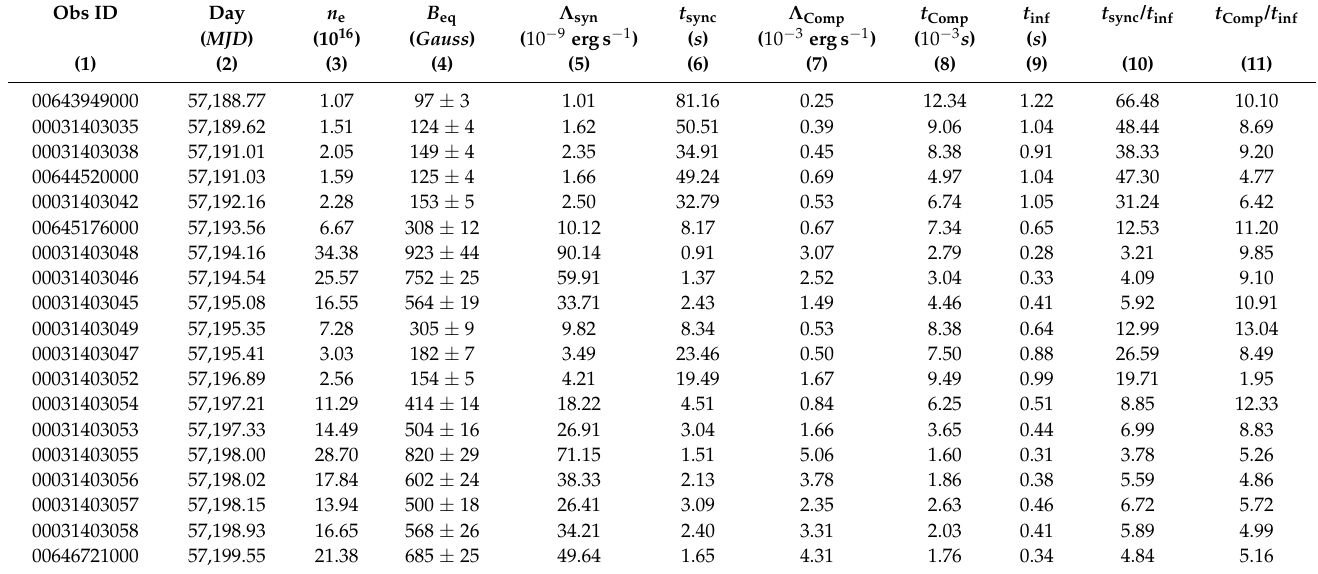
Table 4. Magnetic field and Resonance